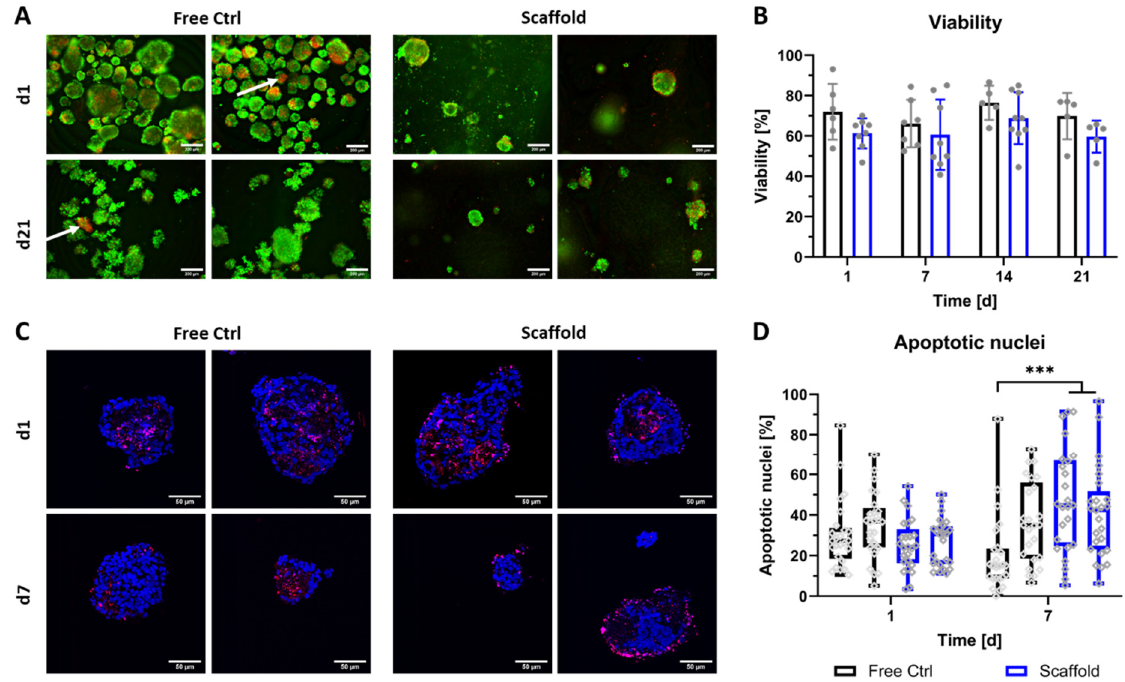
Figure 2. Viability of bioprinted NICC. ( A ) Live/dead staining of free control and bioprinted (“Scaffold”) NICC, representative images taken on d1 and d21 after printing, scale bars = 200 µm. White arrows indicate single islets with a majority of dead cells; ( B ) Semi-quantitative assessment of islet viability on the basis of live/dead stainings as shown in A. Mean ± SD, n ≥ 5, >25 NICC each. Repeat experiments are depicted as grey dots. Due to a limited number of samples, not all time points and conditions were analysed in all repeat experiments, which resulted in an n = 5–7 for free control, and an n = 5–9 for bioprinted scaffolds; ( C ) TUNEL staining for apoptotic nuclei in free control and bioprinted (“Scaffold”) NICC, representative images of samples fixed on d1 and d7 after printing, scale bars = 50 µm; ( D ) Quantitative analysis of percent apoptotic nuclei per islet. Mean ± SD, n = 2, 25 NICC each, *** p < 0.001. Repeat experiments depicted as neighbouring box plots, grey dots indicate individual islets.